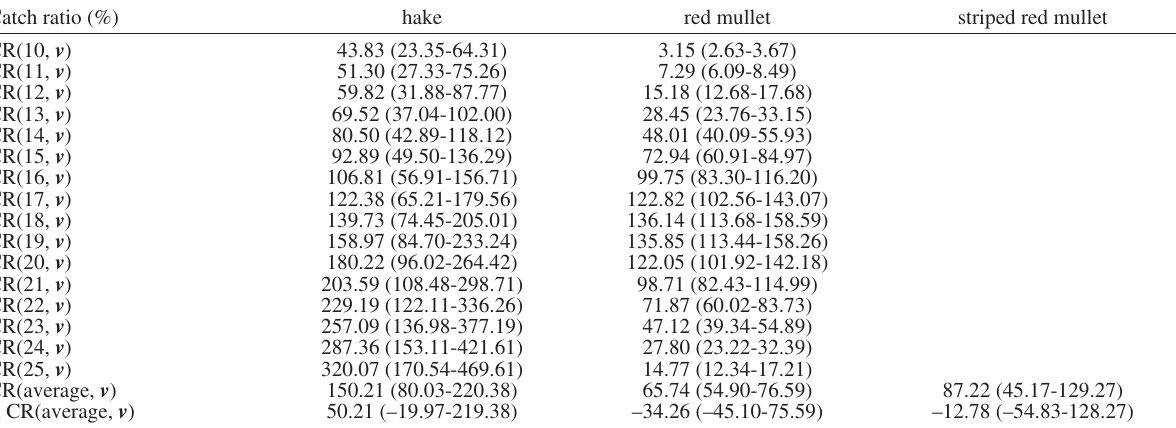
(Table 2). The fit statistics of the models are given in Table 3. The p-values obtained were above 0.05 for